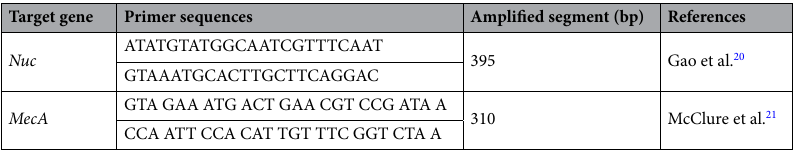
Table 1. Sequences of target genes and amplicon sizes specific for S. aureus in the current